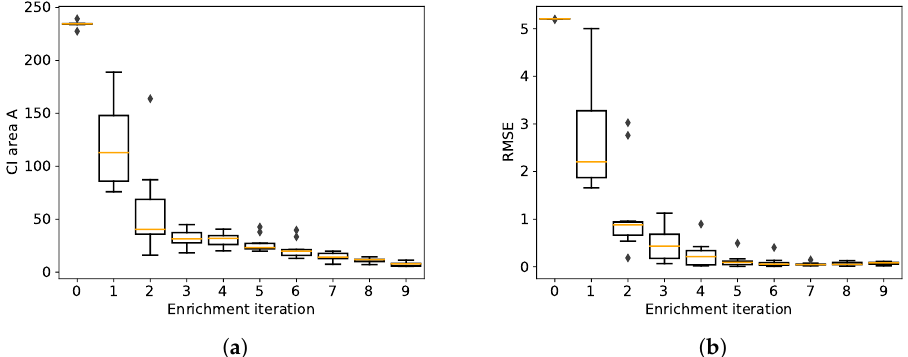
Figure 10. Boxplots for 10 repetitions of the estimation of the quantile confidence area ( a ) and root mean square error ( b ) along the 10 active-learning